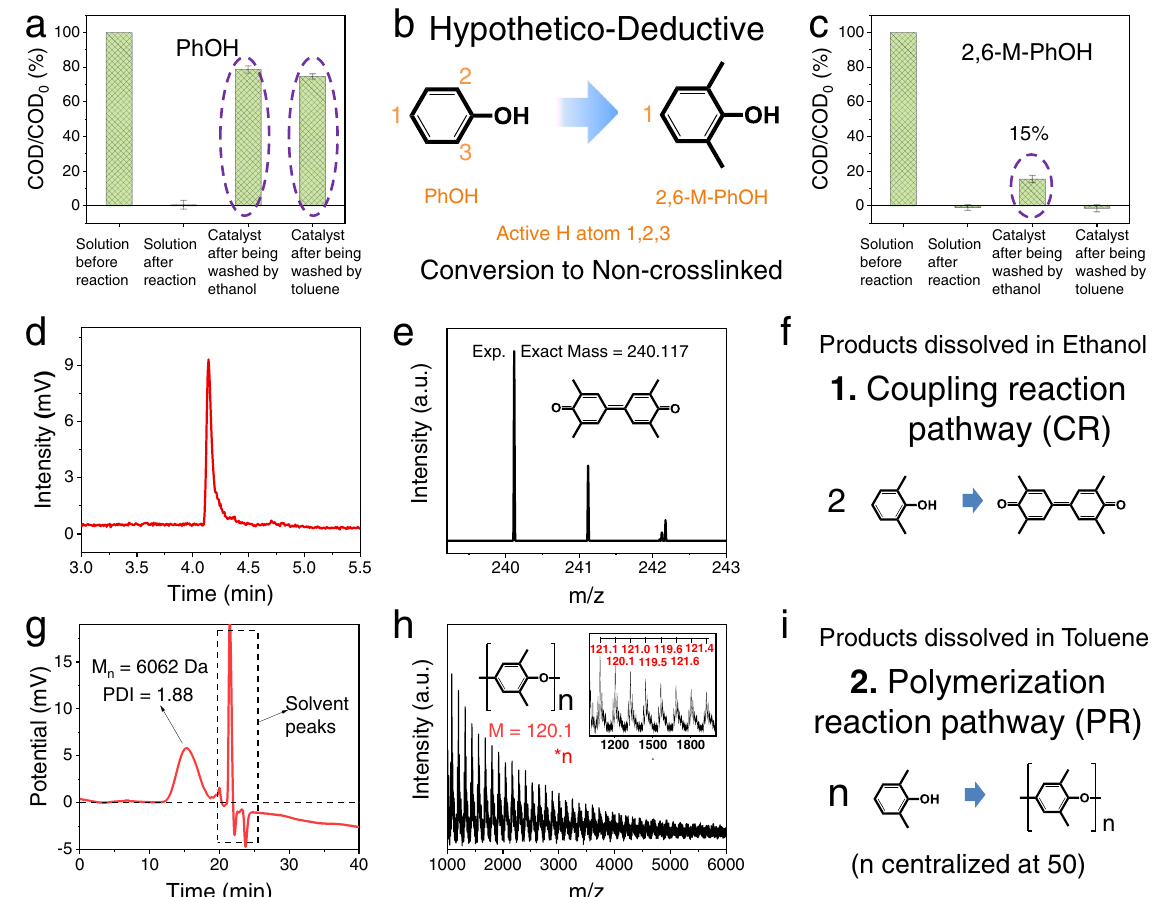
Fig. 3 Reaction pathway analyses of DOTP. a Residual COD of the reaction solution and of the reacted Co 3 O 4 after elution with different solvents in the Co 3 O 4 /PMS/PhOH system. b Active hydrogen atoms of PhOH and 2,6-dimethylphenol. c Residual COD of the reaction solution and of the reacted Co 3 O 4 after elution with different solvents in the Co 3 O 4 /PMS/2,6-dimethylphenol system. d , e Liquid chromatogram ( d ) and mass spectrum ( e ) of the products washed off by ethanol in c . The theoretical exact masses of 3,3,5,5-tetramethyl-4,4 ’ - biphenylquinone including isotopes are 240.12 (100%), 241.12 (17.3%), 242.12 (1.4%), consistent with the experimental values in e . f Schematic of the coupling reaction pathway. g , h Gel permeation chromatogram ( g ) and MALDI-TOF-MS spectrum ( h ) of the products washed off by toluene in c . The polymer dispersity index (PDI) of 1.88 indicates that the molecules centrally weighted at 6062 Da had a narrow weight distribution. The inset in h is the partially enlarged view of the MALDI-TOF-MS spectrum, in which the mean mass interval of 120.1 matches the polymeric unit of poly (2,6-dimethyl-1,4-phenylene oxide) (PPO). i Schematic of the polymerization reaction pathway. Exp. experimental, M n , number-average molecular weight, M theoretical value of the molar mass of the polymeric unit, N degree of